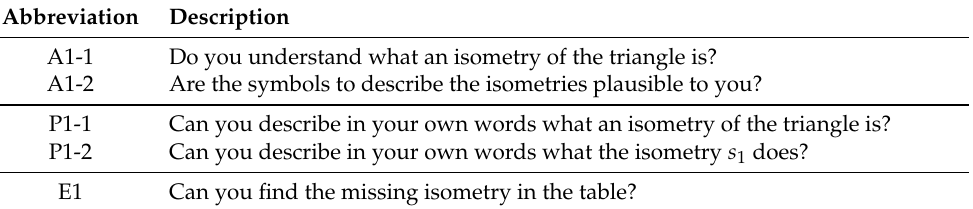
Table A1. Overview and descriptions for all units included in the interview regarding key idea 1 ( Isometries of the triangle , cf. Table 1). A stands for acceptance, P for paraphrasing, and E for exercise.